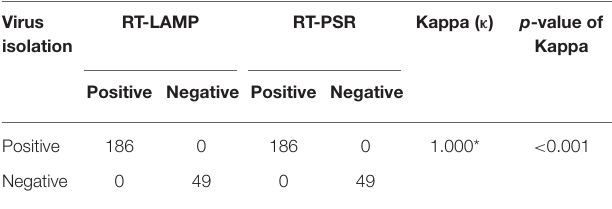
TABLE 2 | Comparison of virus isolation, RT-PSR and RT-LAMP for detection of N-GoAstV in clinical